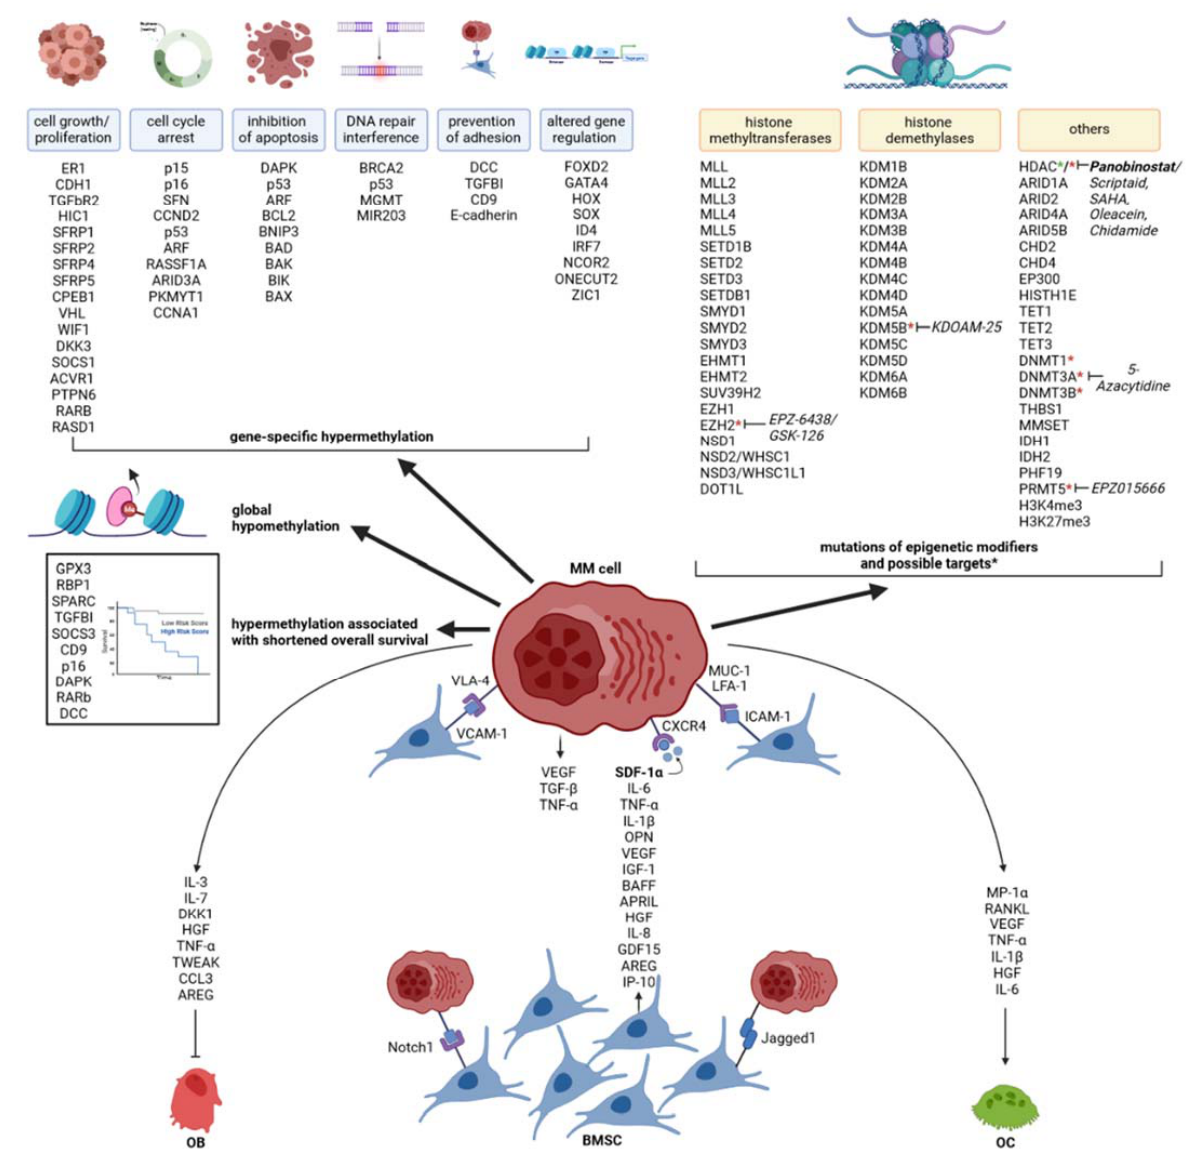
Figure 1. Schematic representation of the most-known epigenetic aberrations in MM and their interplay with the bone marrow microenvironment. The DNA methylation changes are categorized according to the main cellular pathway that they dysregulate. The epigenetic modifiers reported to be mutated and hypermethylated genes associated with shortened survival are indicated separately. * Identifies potential pharmacological targets. Approved compounds are signaled in bold. MM cell: multiple myeloma plasma cells, OC: osteoclasts, OB: osteoblasts and BMSC: bone marrow stromal cells.